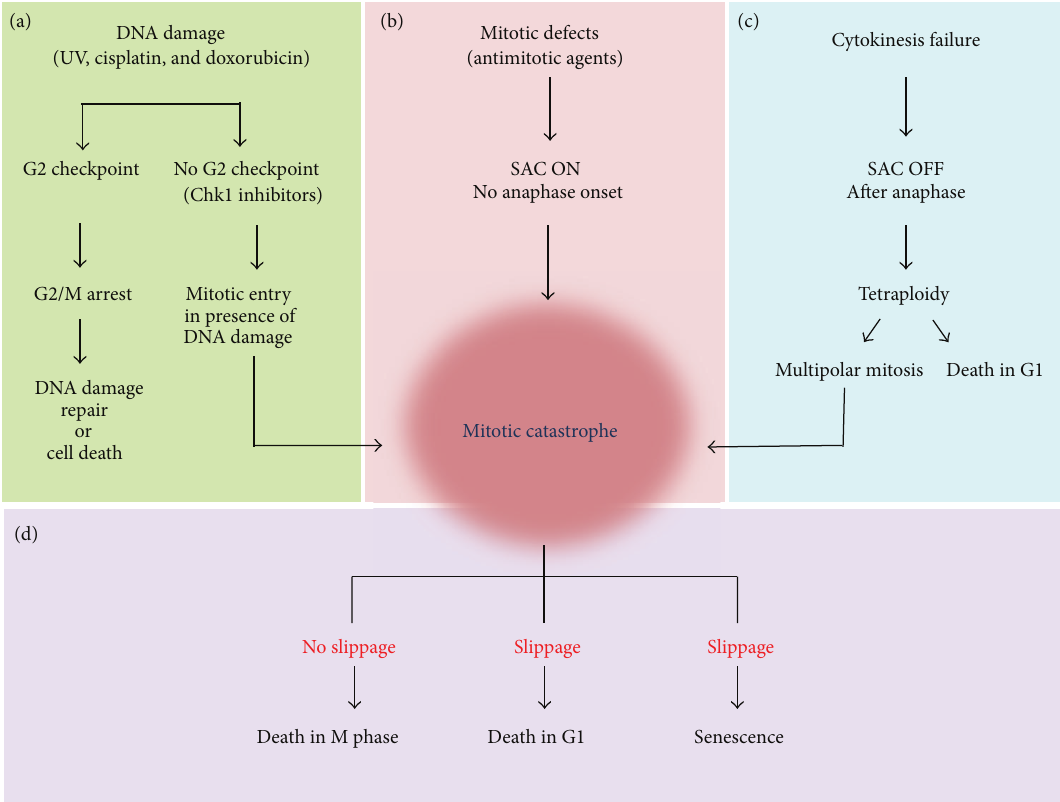
Figure 2: Mechanisms of mitotic catastrophe. (a) Cells with an abrogated G2 checkpoint will enter mitosis prematurely in the presence of damaged DNA and undergo segregation defects leading to mitotic catastrophe. (b) Cells with defects in mitotic apparatus and/or machinery required for faithful chromosome segregation fail to satisfy the spindle assembly checkpoint (SAC) and undergo prolonged mitotic arrest and mitotic catastrophe. (c) Cytokinesis defects that occur after anaphase will lead to a tetraploid progeny that will undergo mitotic catastrophe in the next M-phase. (d). Following activation of mitotic catastrophe, cells arrested in mitosis have three fates; they will undergo death in mitosis in the presence of cyclin B, or cyclin B levels will gradually fall allowing the cells to undergo slippage and exit mitosis where they subsequently undergo death in G1. Alternatively, cells can undergo senescence following